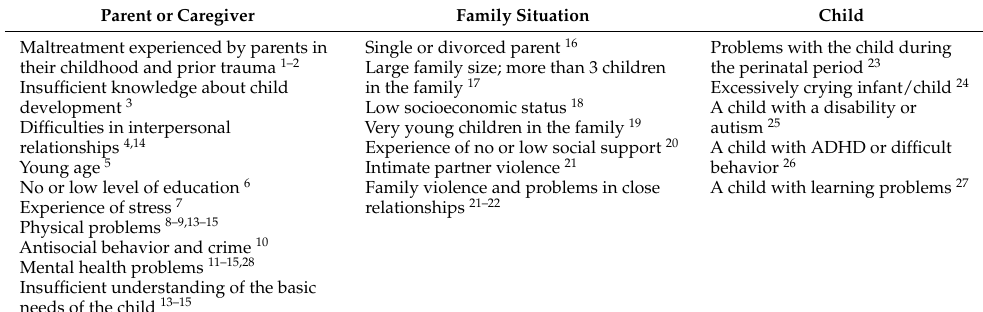
Table 1. Risk factors concerning the parent or caregiver, family situation, and